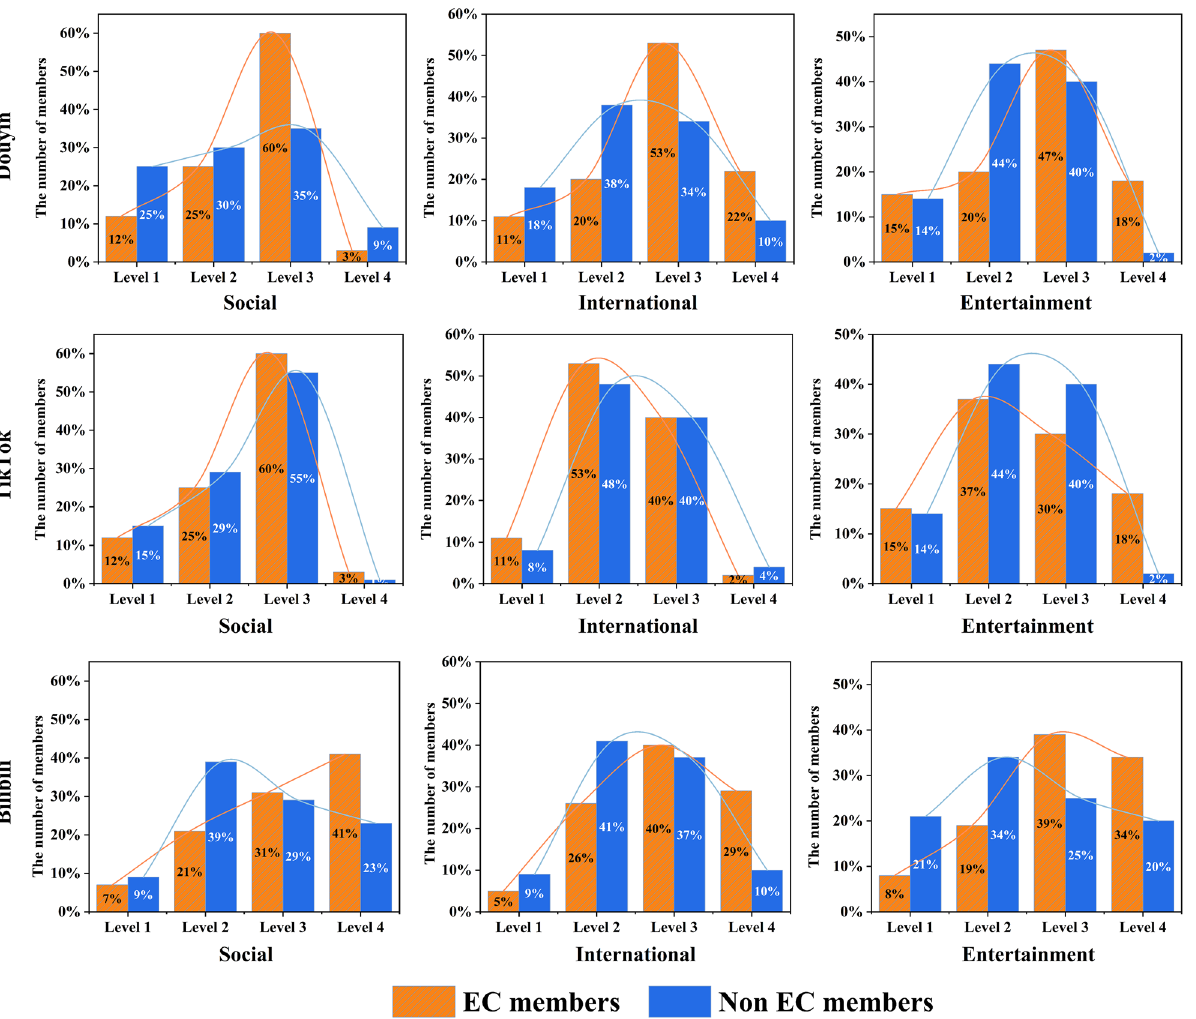
Figure 9. Willingness to self-disclose of users in the ECs and TCG. In the platform dimension, Douyin and Bilibili’s EC members’ willingness to self-disclose is mainly concentrated in Level 3 and Level 4, which